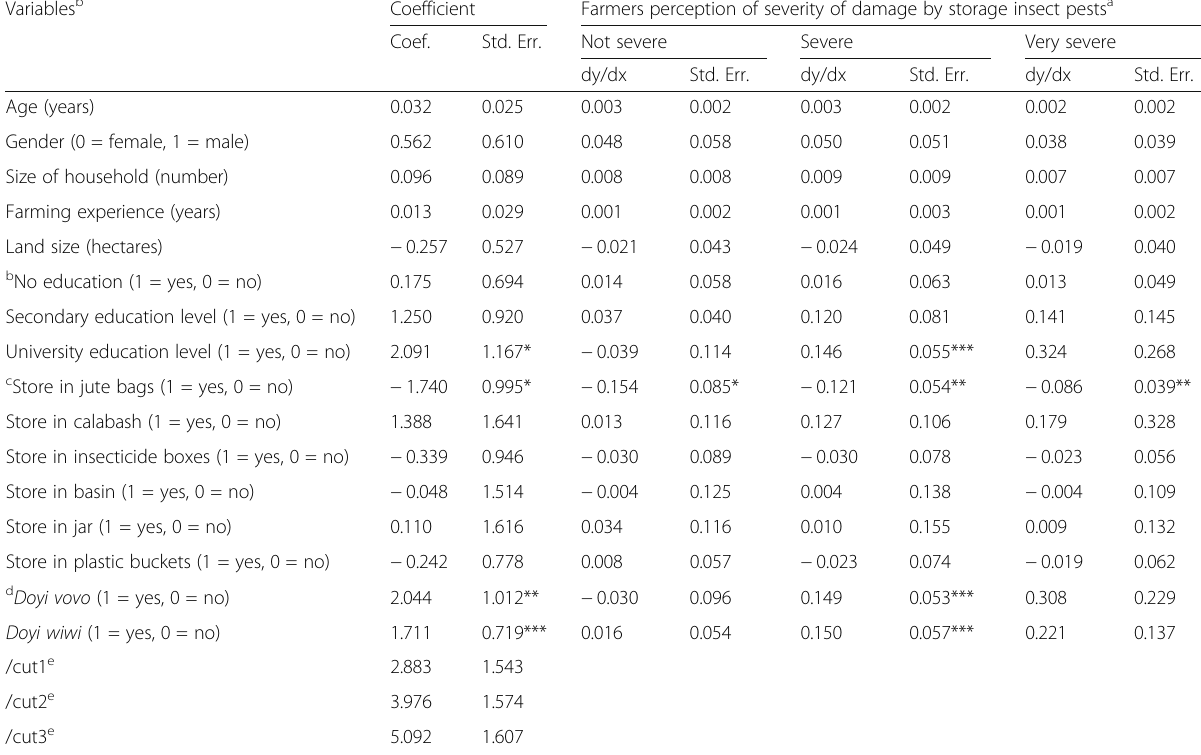
Table 3 Ordered logit results of factors influencing farmers ’ perception about severity of storage pest attacks on Kersting ’ s groundnut Variables b